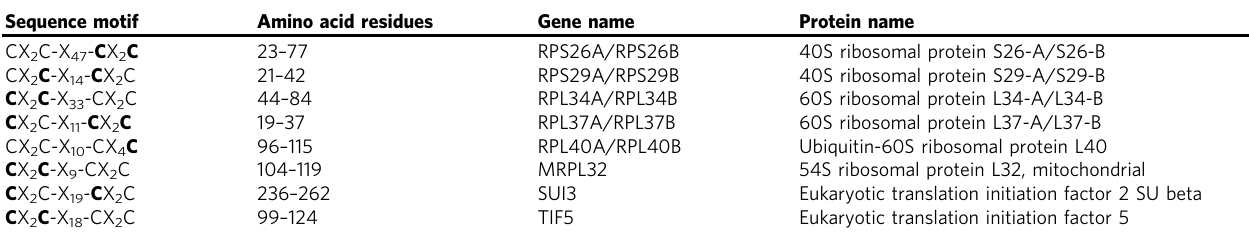
Table 1 Sequence motif in H 2 O 2 -sensitive proteins Sequence motif Amino acid residues Gene